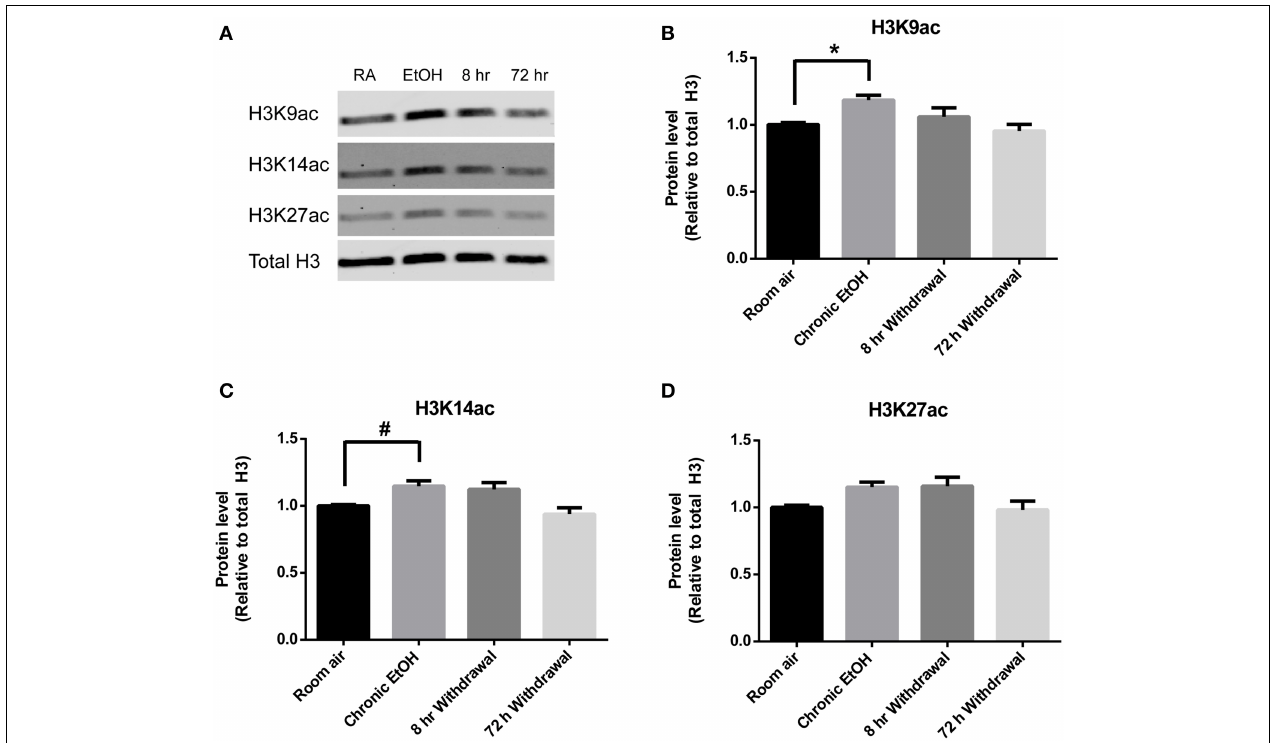
significant effect of EtOH on levels of H3K14ac ( p < 0 . 01 ) and a trend for increased levels immediately following EtOH exposure, and (D) a significant effect of EtOH on levels of H3K27ac ( p < 0 . 05 ). * p < 0 . 01 , # p = 0 . 056 , n = 6 /group, data presented as mean ±